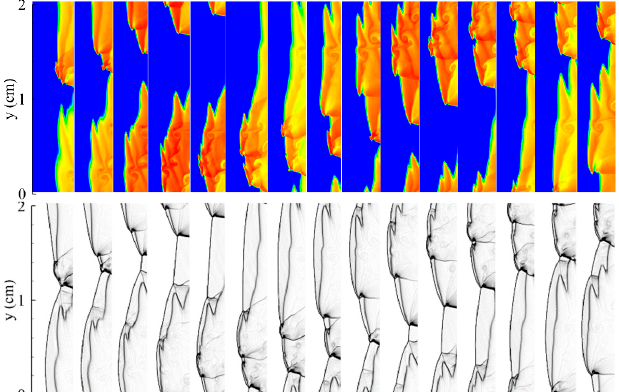
Figure 10. Weakening of the triple points at the detonation front. Density gradient ( top ); OH mass fraction ( bottom ) .